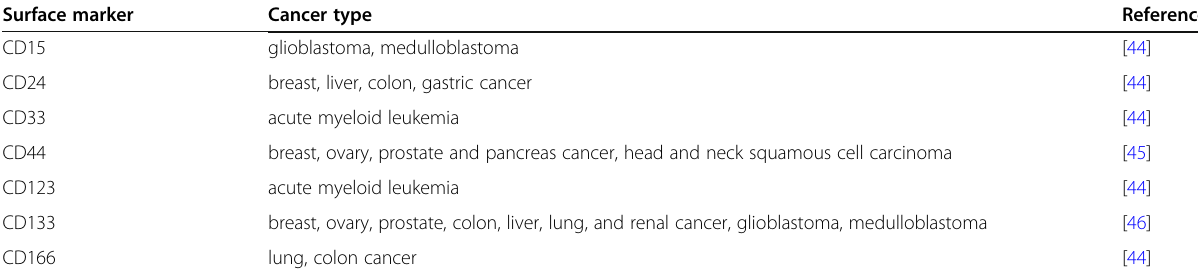
Table 1 Representative surface markers to identify CSCs in various types of cancers Surface